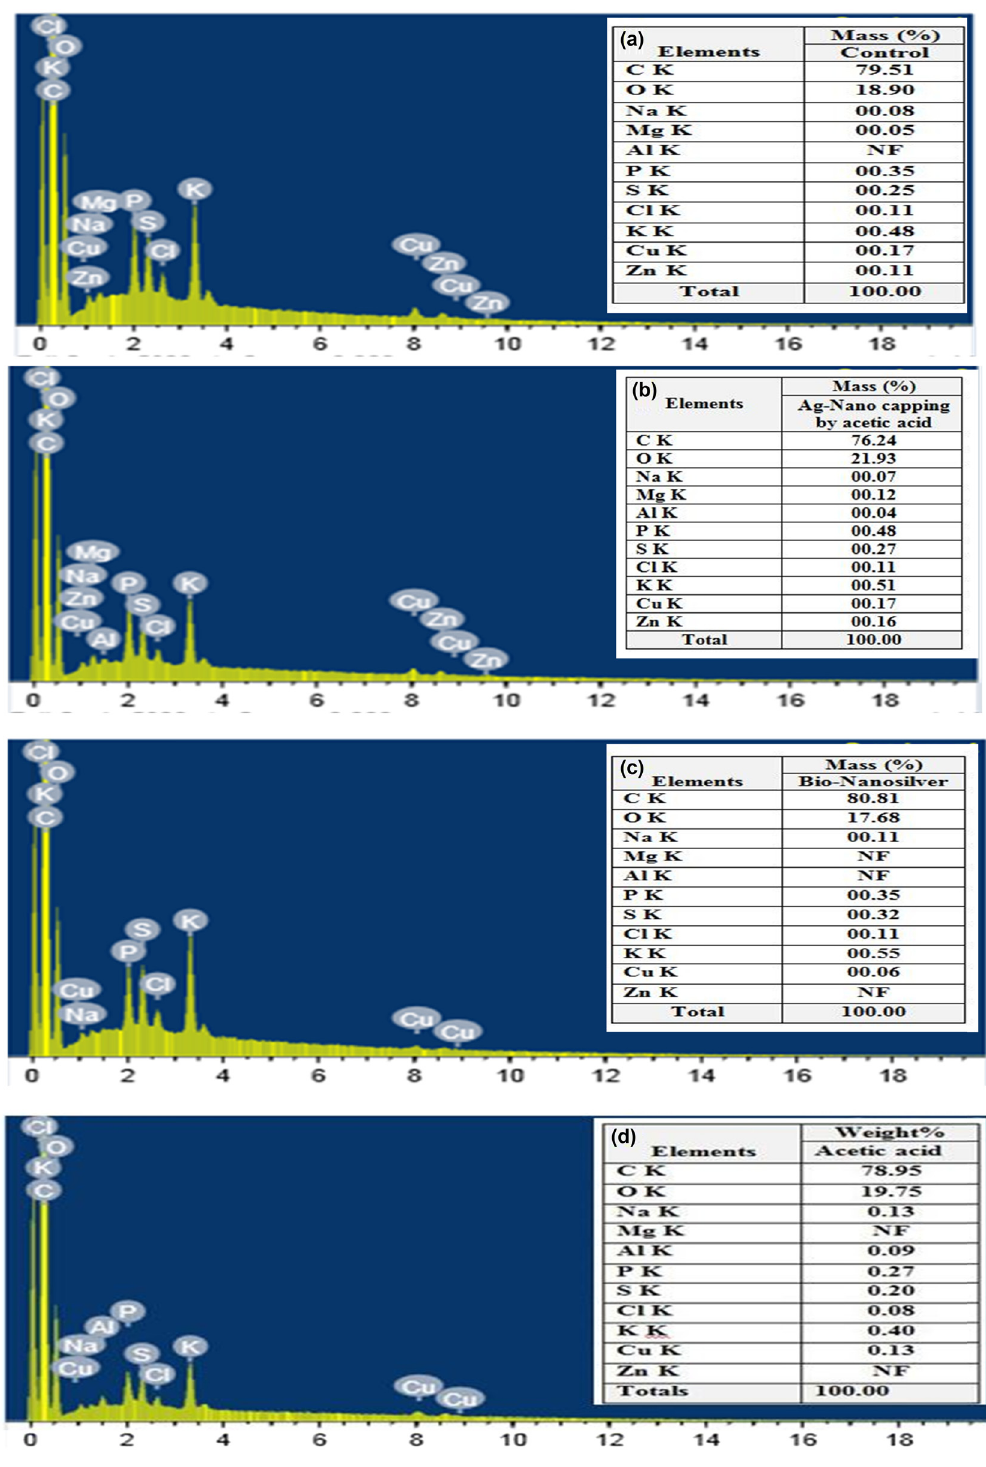
Figure 5: EDS analysis of boiler meats: ( a ) control, ( b ) treated with biogenic AgNPs coated with acetic acid, ( c ) treated with biogenic Ag NPs, and ( d ) treated with acetic